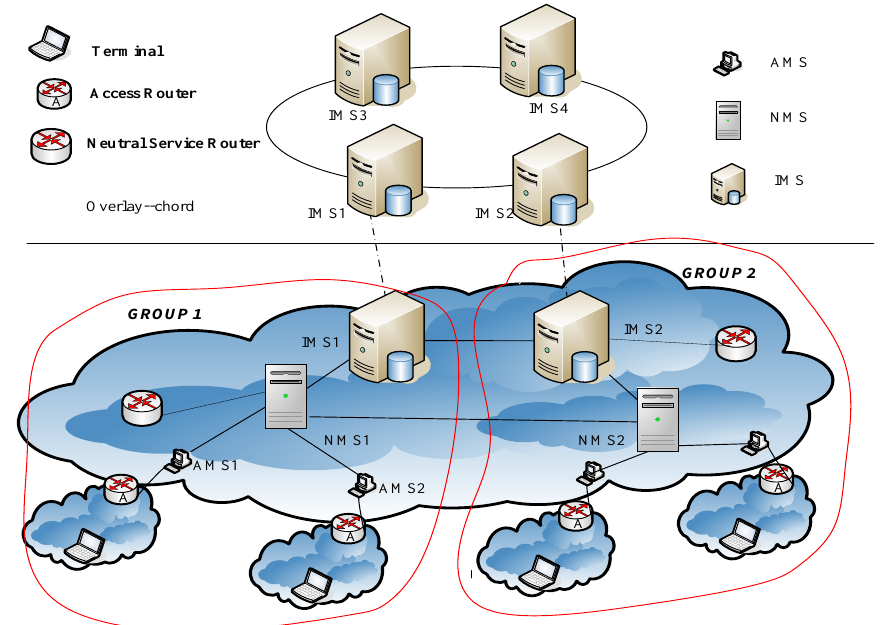
Figure 2. Hierarchical mapping architecture on active-degree (HMAA).